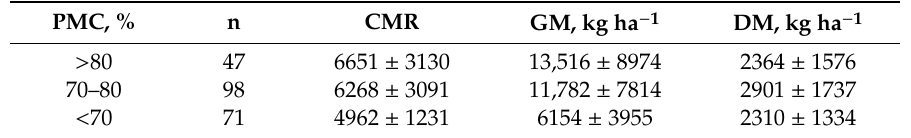
Table 3. Mean ± standard deviation of the parameters measured in the pastures of the eight fields used in the validation